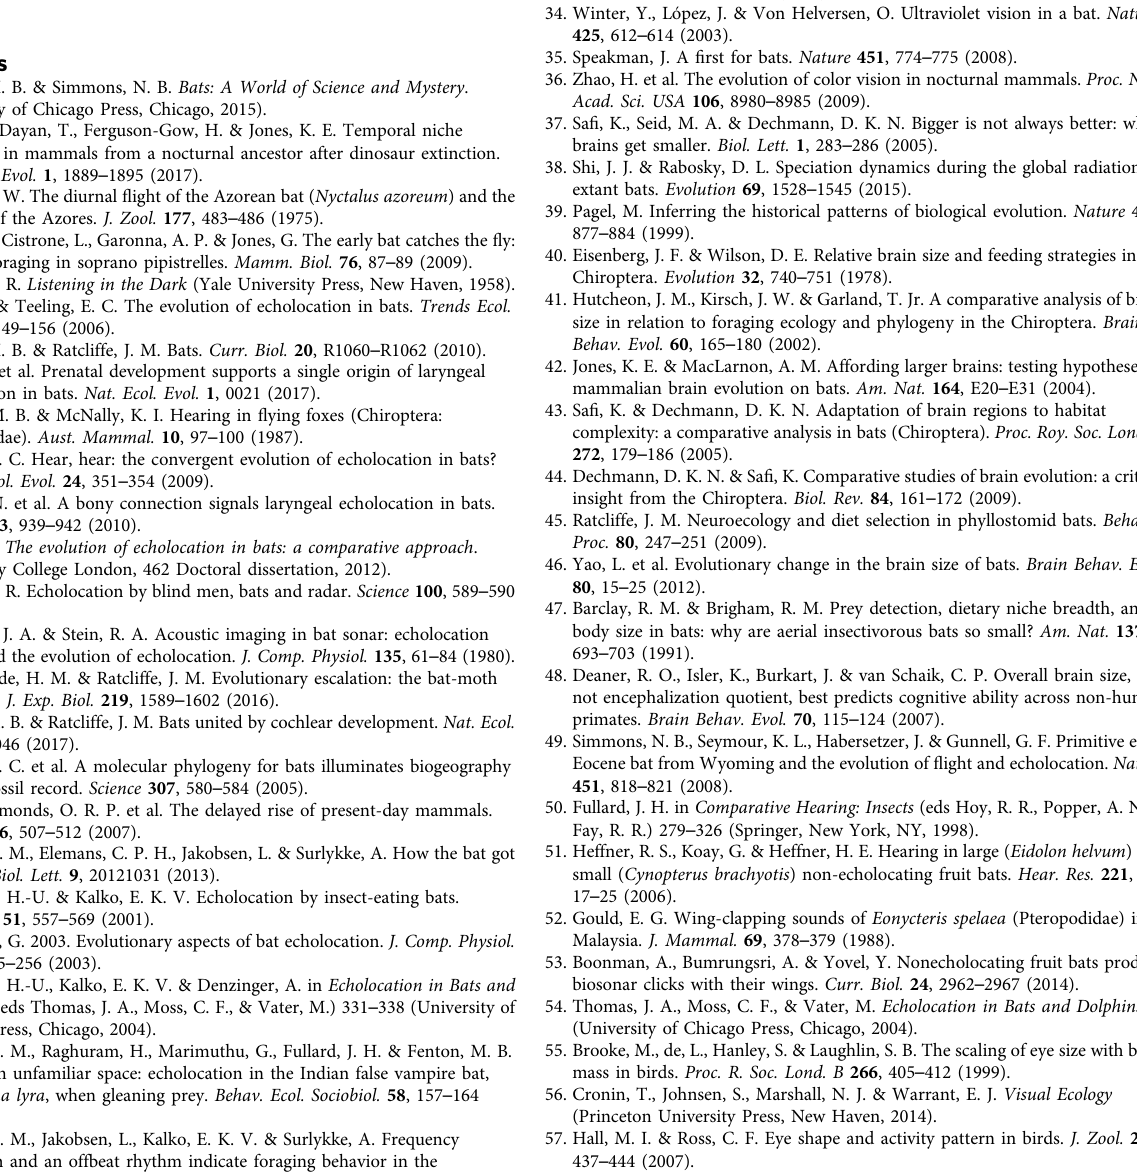
Maximum Likelihood 77 with R-package ape 78 . Brain and eye mass were positively correlated with body mass. Thus, we generated phylogenetic residuals for log-transformed brain mass, eye mass, and brain region masses on body mass, and tested for differences in these residuals across our four call type categories and our three foraging categories. Summaries for the results are provided in-text and in Supplementary Tables 1 – 6. We also used Pagel ’ s binary character correlation test to explored whether there were signi fi cant correlations between where bats roost (i.e., internally, externally) and (i) absolute and relative eye size or (ii) echolocation call types 74 . Further, using the same test, we tested the prediction that among predatory bats, there would be a signi fi cant correlation between CF echolocation and the loss of functionality in SWS opsin genes. Last, we plotted regressions of log transformed eye mass on body mass in the fi ve most species rich bat families, while accounting for the phylogenetic non- independence among